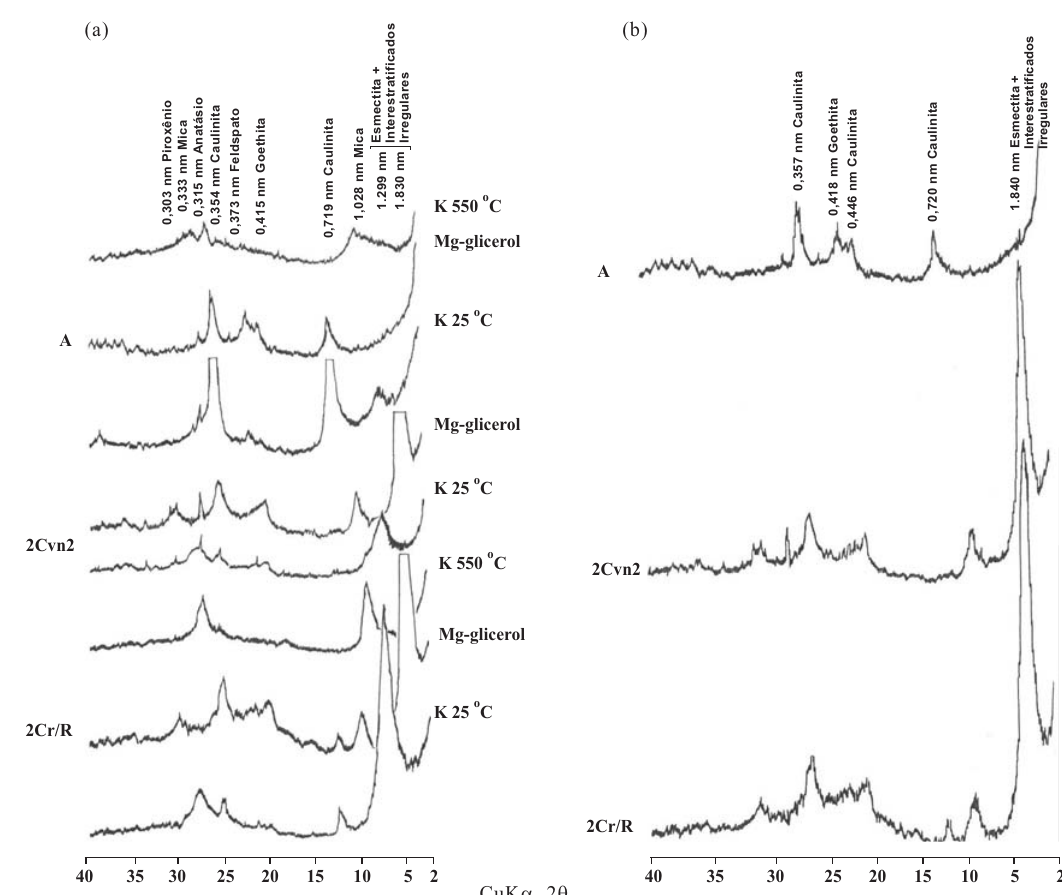
Figura 3. Difratogramas de raios X da fração argila do perfil 6 – Cambissolo Háplico Sódico vertissólico. (a) todos os tratamentos; (b) saturado com